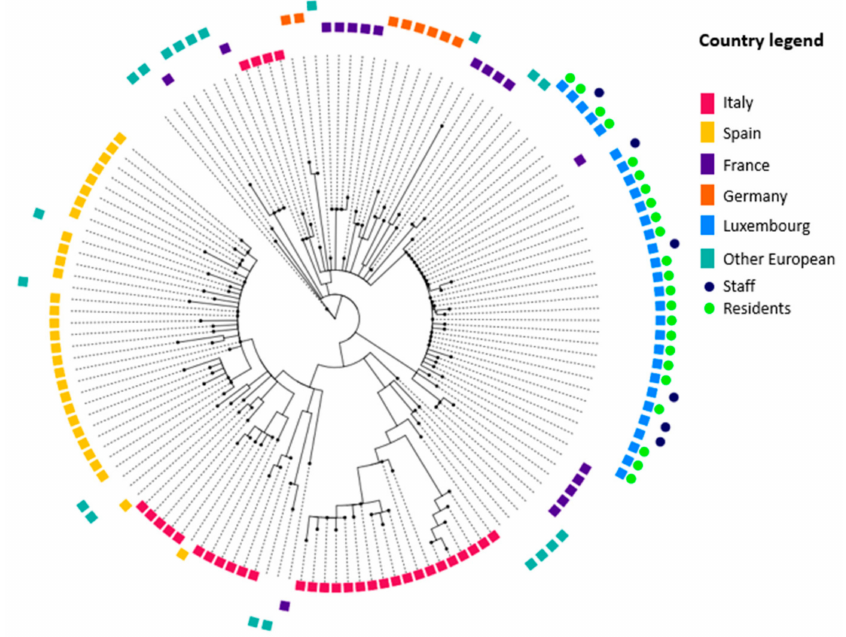
Figure 2. Phylogenetic tree of B.1.1.420 cases comparing resident and staff status during a long-term care facility SARS-CoV-2 outbreak in February–March 2021 in Luxembourg with reference sequences from other European